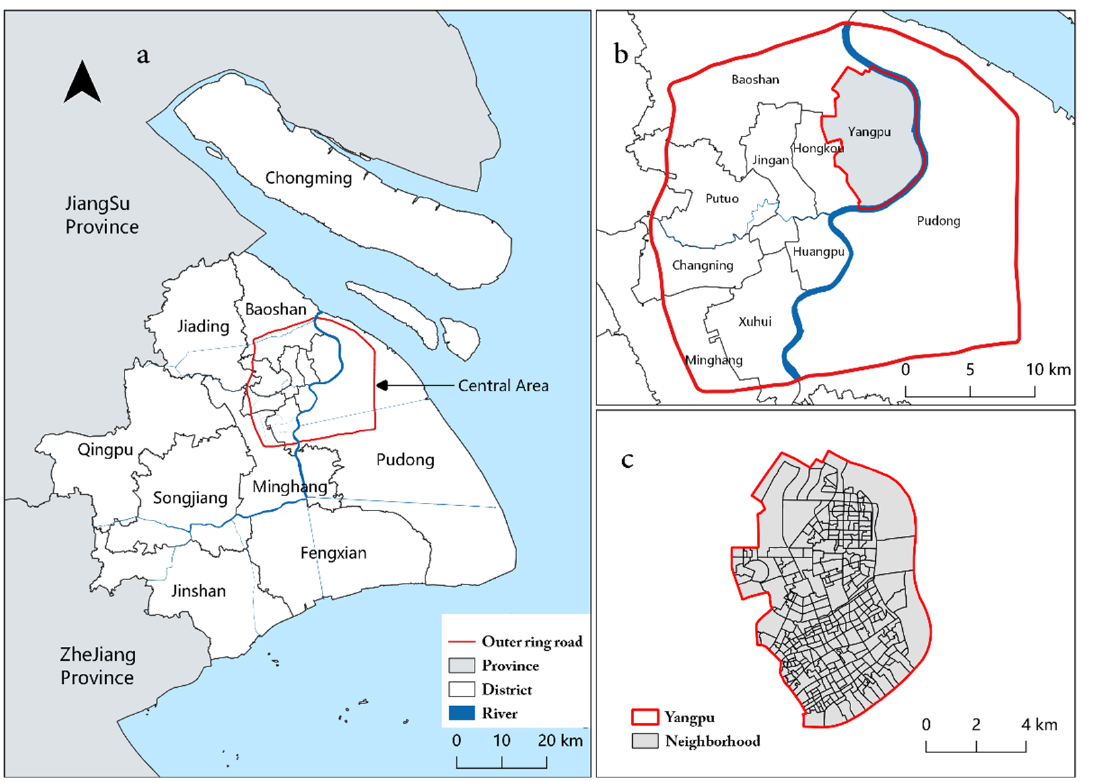
Figure 1. Geographical setting of Shanghai: ( a ) administration levels; ( b ) inner center; ( c ) neighborhood levels in the district.